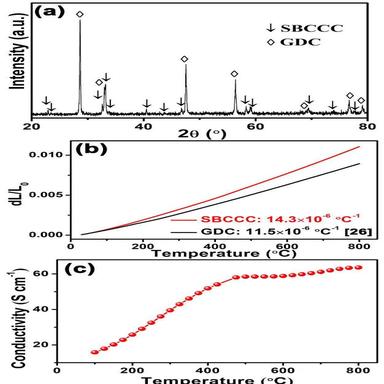
(a) XRD of SBCCC and GDC mixture that calcined at 950 °C for 10 h. The (b) thermal expansion characteristic and (c) electrical conductivities of SBCCC in air. The thermal expansion data of GDC electrolyte was given in (b) for comparison.